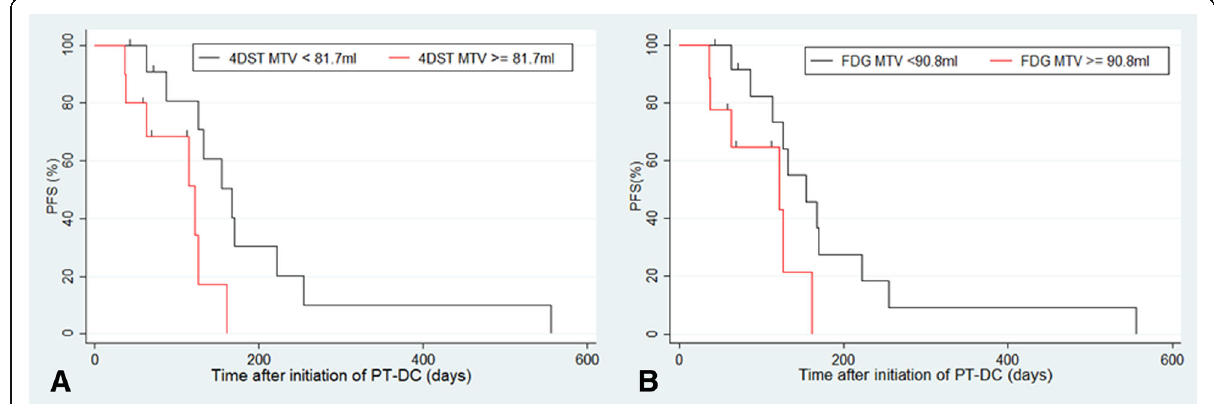
Fig. 2 Kaplan-Meier analysis for progression-free survival (PFS) in patients with advanced non-small-cell lung cancer treated with platinum-based doublet chemotherapy (PT-DC). a PFS according to metabolic tumor volume (MTV) of baseline 4DST. b PFS according to MTV of baseline